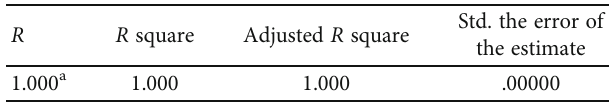
Table 4: Model summary of multiple linear regression inferential